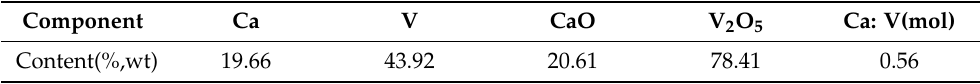
Table 4. Chemical composition of calcific